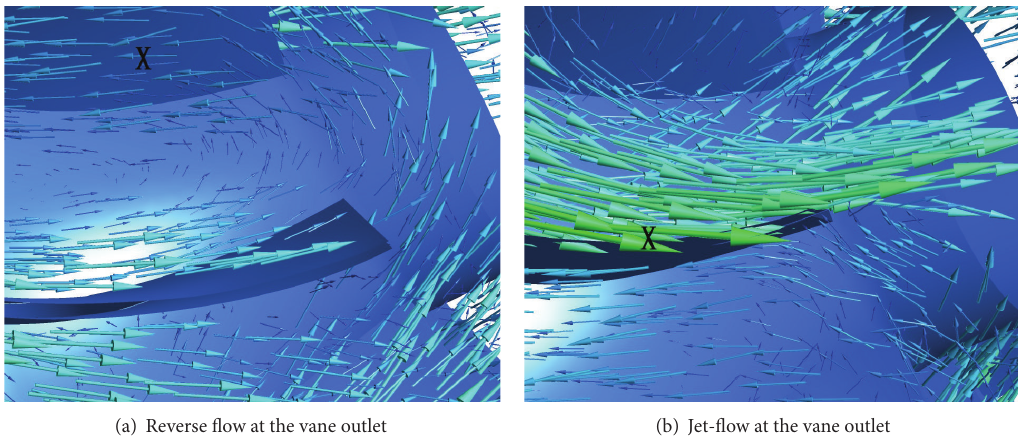
Figure 19: Instantaneous velocity vectors near the TE of the diffuser at 0.65 𝑄